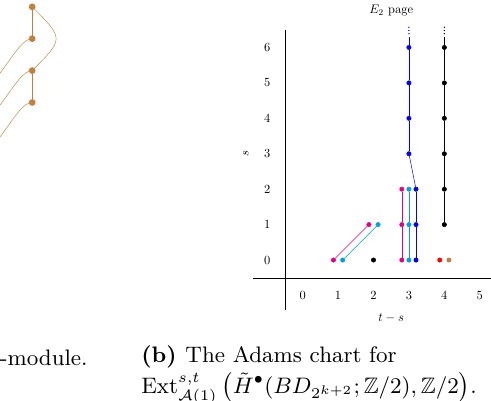
Figure 4. The A (1) -module structure and Adams chart for calculating spin bordism of BD 2 n , for even n